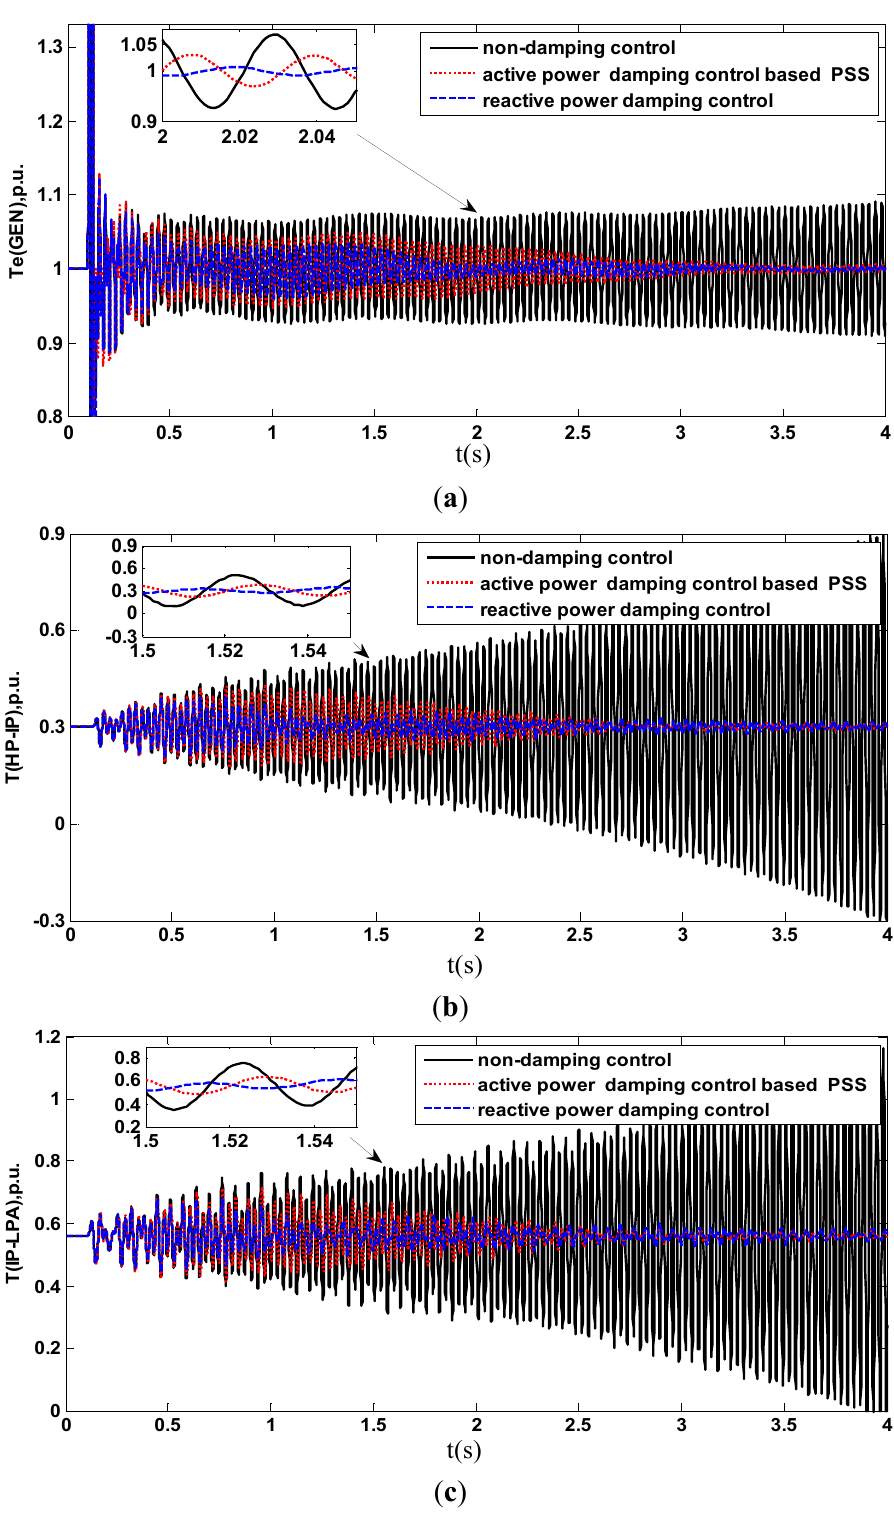
Figure 9. Dynamic performance of the turbo-generator during and after clearing fault, ( a ) Electromagnetic torque response of the turbo-generator; ( b ) HP-IP torsional torque response of the turbo-generator; ( c ) IP-LPA torsional torque response of the turbo-generator; ( d ) LPA-LPB torsional torque response of the turbo-generator; ( e ) LPB-GEN torsional torque response of the turbo-generator; ( f ) GEN-EXC torsional torque response of the